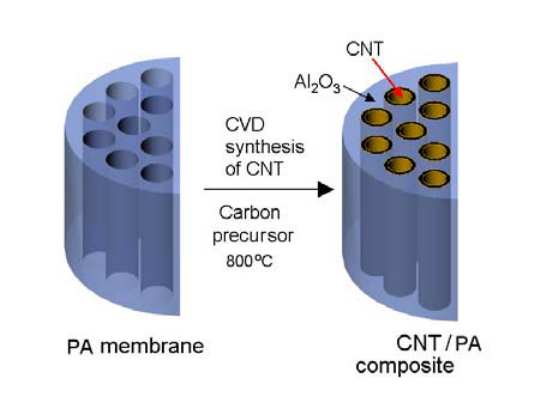
Figure 1. Schematic of fabrication CNT/PA membrane composites by CVD growth of carbon nanotubes inside of porous alumina oxide